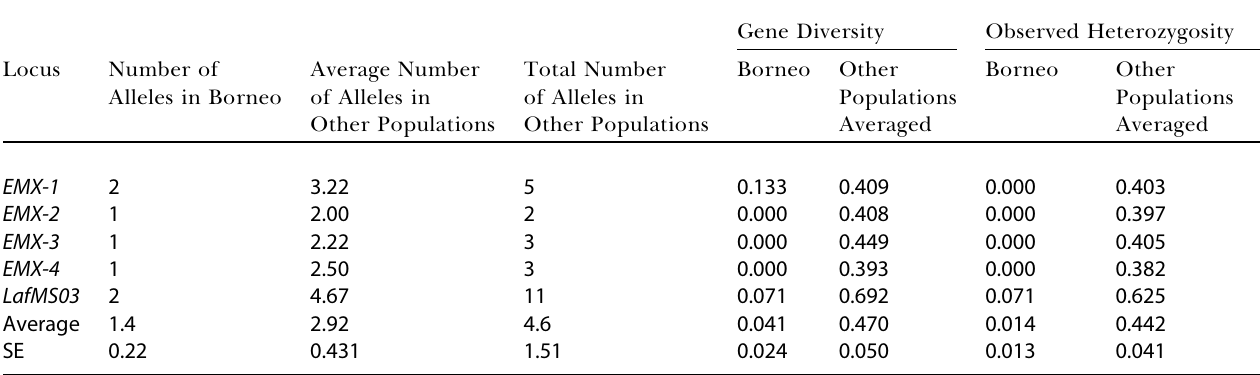
Table 1. Comparison of Measures of Genetic Variation at Individual Loci in Borneo with Those of the Other